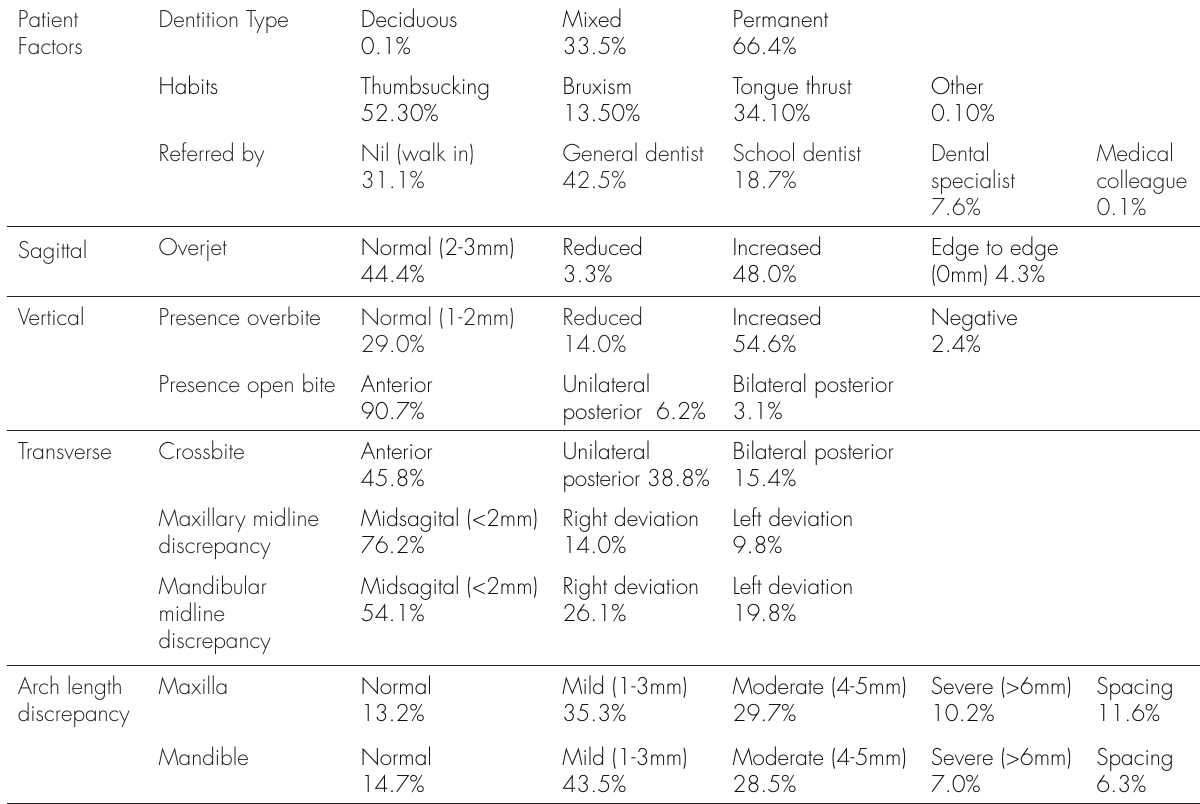
Table III. Breakdown of orthodontic discrepancy by